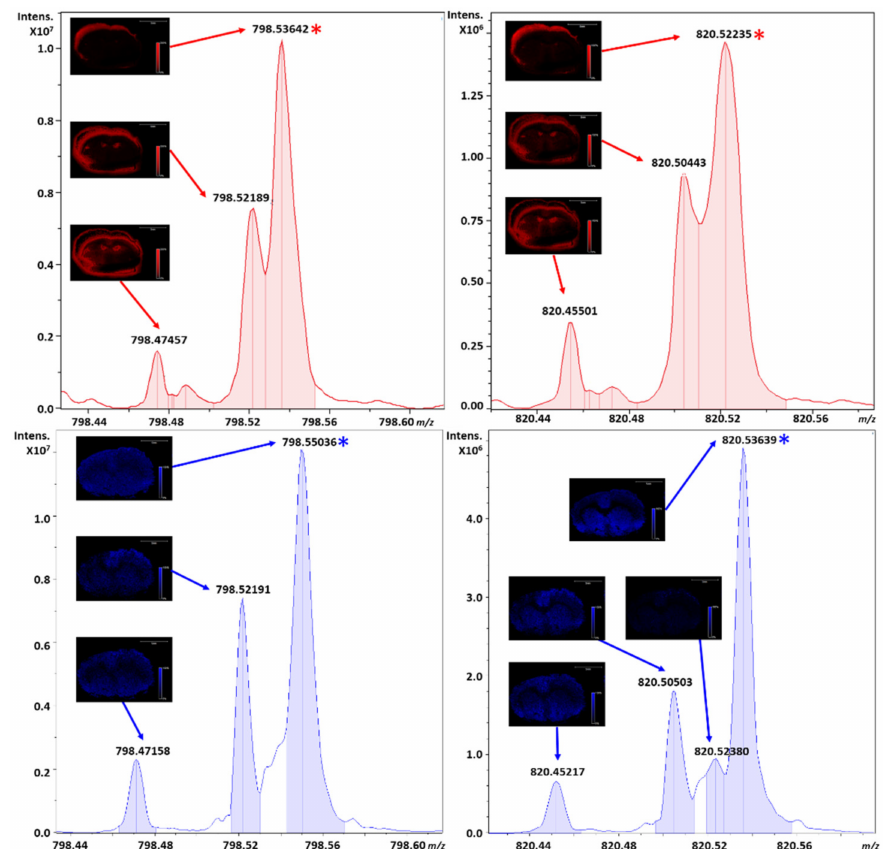
Figure 5. Individual zoomed views from the averaged spectra of all pixels of the potassiated adducts of PC 32:0 and PC 36:4 from m / z ranges of 794.42 to 798.61 and 820.43 to 820.57, respectively. This area of 210 mDa contains several species annotated with varying resolution from MALDI (top, red) and DESI (bottom, blue). The PC main adduct is marked with an asterisk for each respective